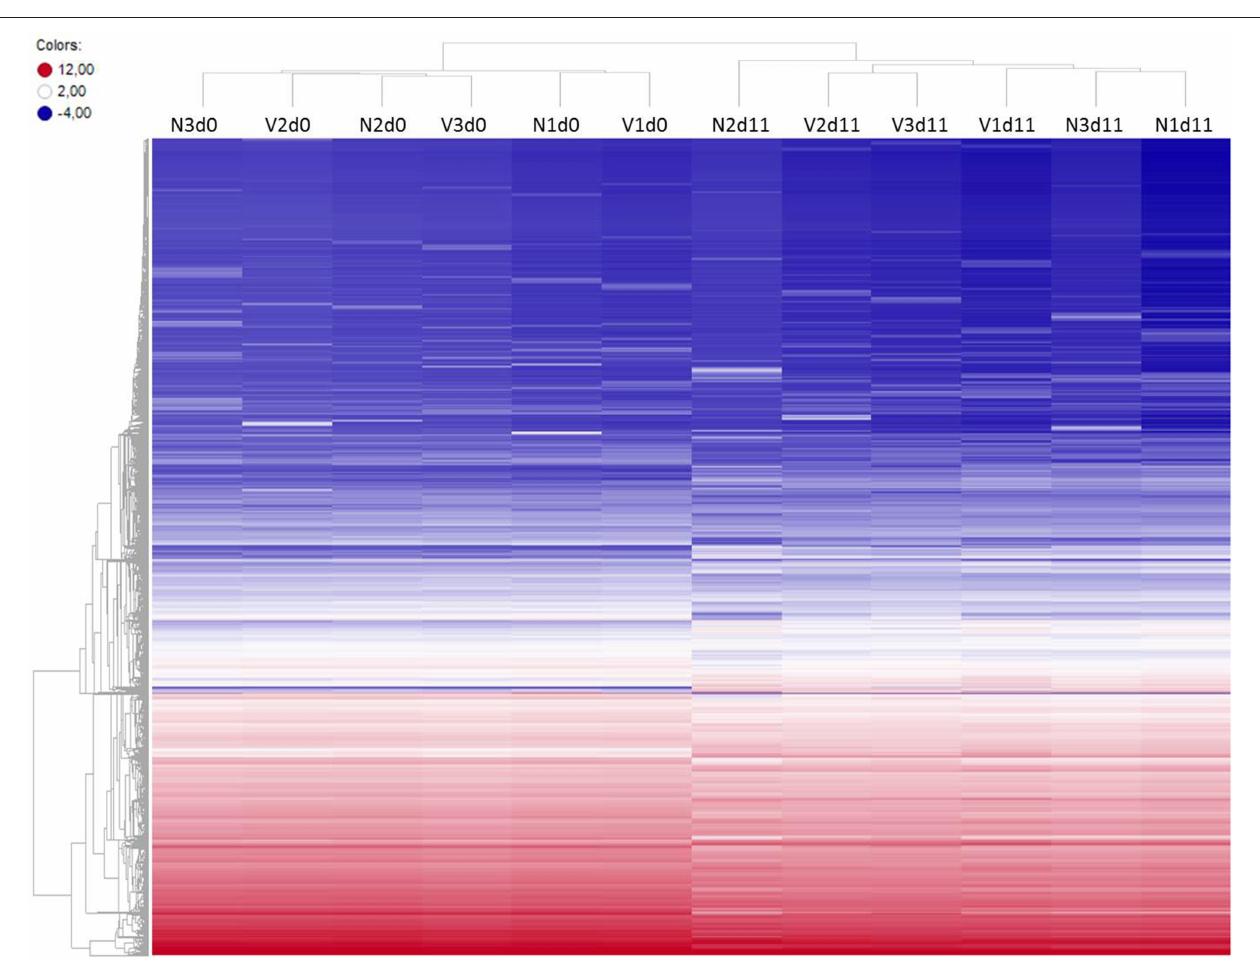
FIGURE 1 | Heatmap of global expression levels of mRNA and lincRNA in the liver of non-vaccinated (N) and vaccinated (V) mice on day 0 p.i. (Nd0, Vd0) and day 11 p.i. (Nd11, Vd11). Expression levels for each sample were hierarchically clustered. Log 2 transformed expression levels range from − 4 to 12 indicated by blue and red color,